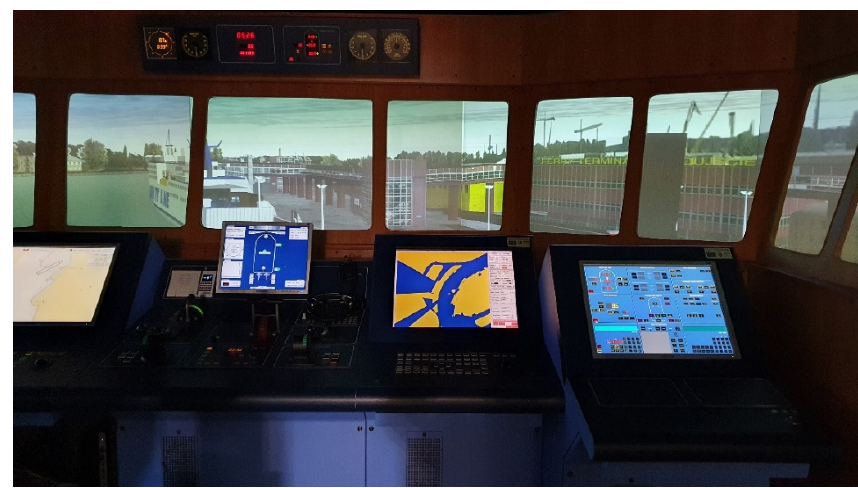
Figure 8. FMBS navigation bridge during berthing scenarios.